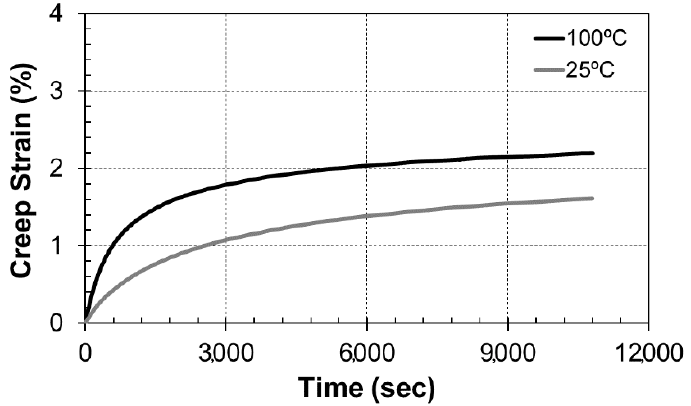
Figure 16. Creep strain as a function of time for a nanocomposite made of 15 v% cellulose and 20 wt. % STO nanoparticles.